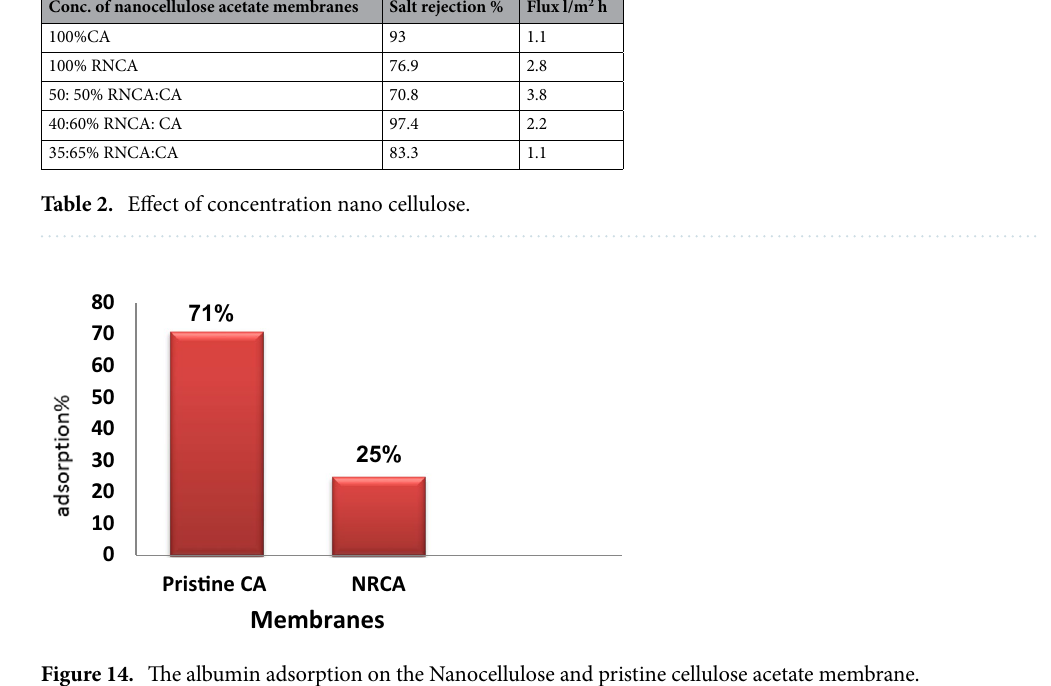
Figure 14. The albumin adsorption on the Nanocellulose and pristine cellulose acetate